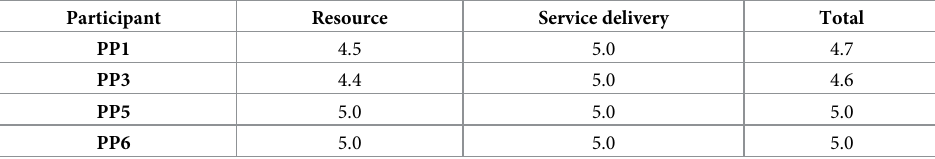
Table 4. QUEST 2.0 scores.